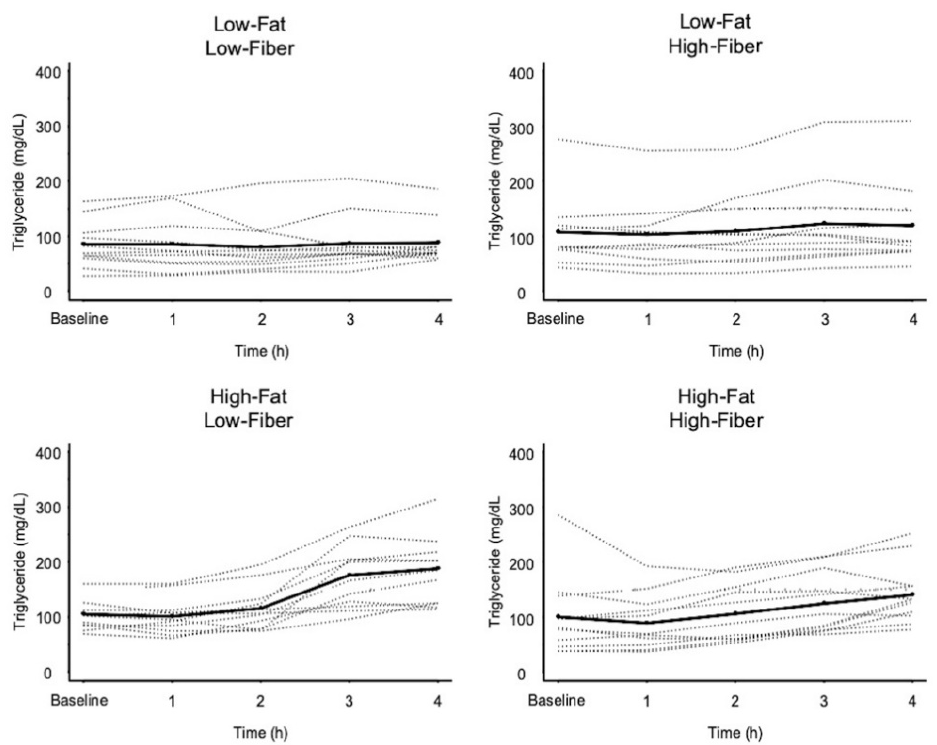
Figure 5. Plasma triglyceride responses to the four meals. Dashed lines represent individual subject responses. Solid line represents mean response for all subjects.